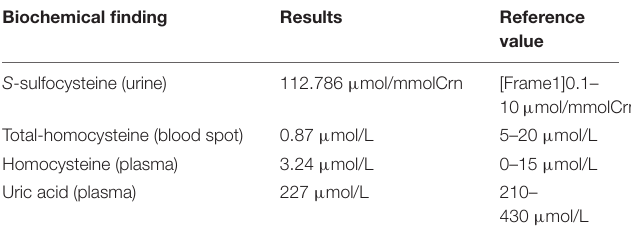
TABLE 2 | Biochemical finding of the case. Biochemical finding Results Reference